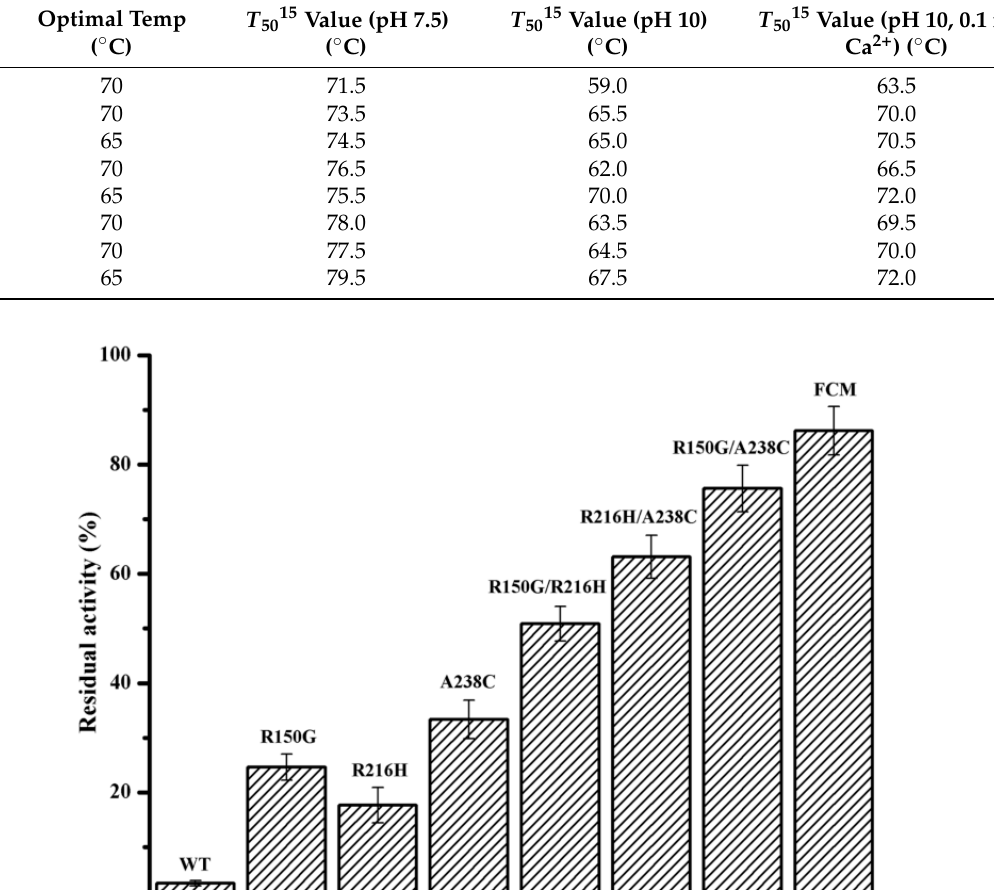
Figure 4. The residual activity of wild-type BacPelA and mutant enzymes under degumming conditions. The residual activity was determined after incubation at 60 ◦ C and pH 10.0 with 0.1 mM Ca 2+ for 4 h. FCM means the final combined mutant R150G/R216H/A238C. The measurements were performed in three independent experiments. Error bars represent standard deviations. To elucidate the effects of these three substitutions on enzyme activity, the specific activities and steady-state kinetic parameters of wild-type BacPelA and mutants R150G, R216H, and A238C were determined at 70 ◦ C. As shown in Table 4, the specific activity of R150G, R216H, and A238C was 759.8 U mg − 1 , 833.7 U mg − 1 , and 965.2 U mg − 1 , respectively, increased by 6.7%, 17.1%, and 35.6%, respectively, compared with wild-type BacPelA (711.8 U mg − 1 ). Note also that the optimal reaction temperature of mutant R216H was changed to 65 ◦ C, 5 ◦ C lower than that for wild-type BacPelA. At 65 ◦ C, the R216H mutant had a specific activity of 888.3 U mg − 1 , increased by approximately 24.8% compared with wild-type BacPelA at its optimal temperature (70 ◦ C). Therefore, all three mutations not only improved the thermostability of the enzyme but also increased the specific